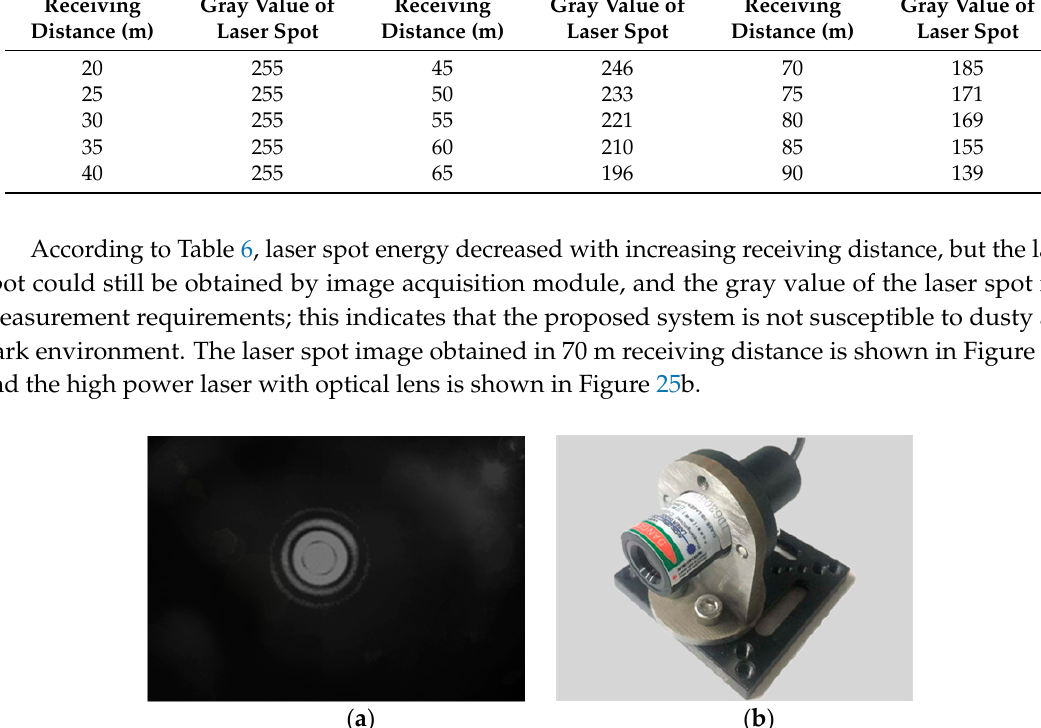
Figure 24. Tunnel environment during construction. ( a ) tunnel construction trolley; ( b ) dusty and dark tunneling environment; ( c ) deformation monitoring during construction; ( d ) tunnel face environment. Table 6. Laser energy transmission test data.